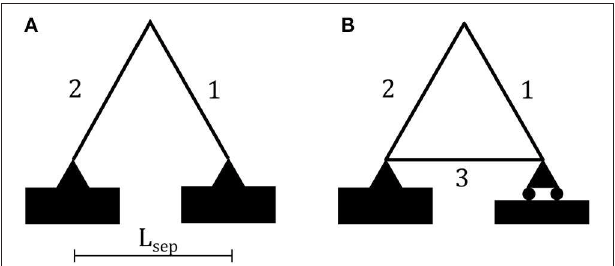
FIGURE 3 | Examples of systems with (A) two elements and (B) three